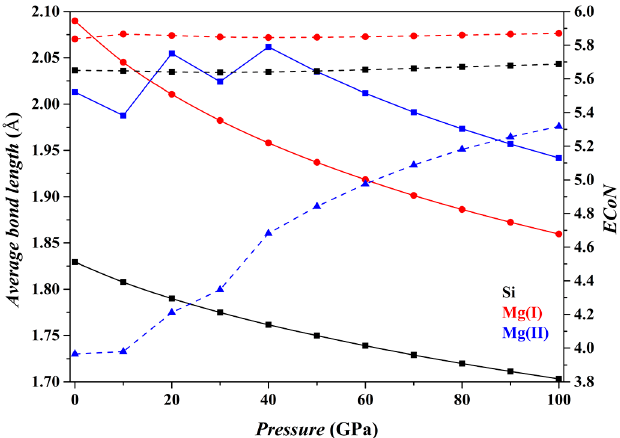
Figure 5. Evolution of the average bond length ( d mean ) and ECoN parameters of the polyhedra of the Fo-IV phase as pressure increases from 0 to 100 GPa (0 K). For the information about the Mg(I) and Mg(II), see Supplementary Tables